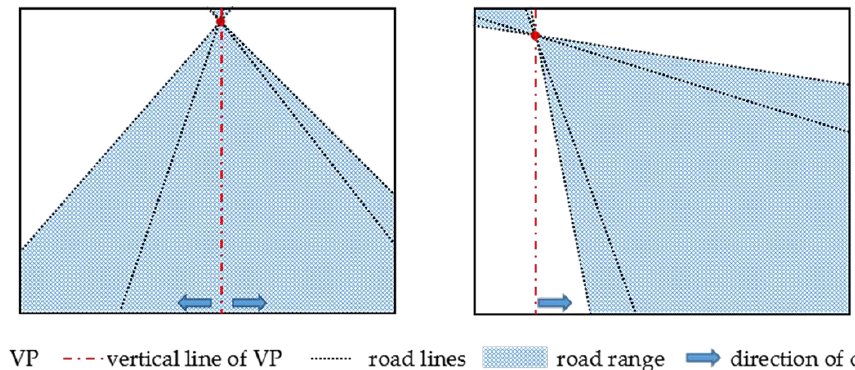
Figure 7. Road ranges extraction.